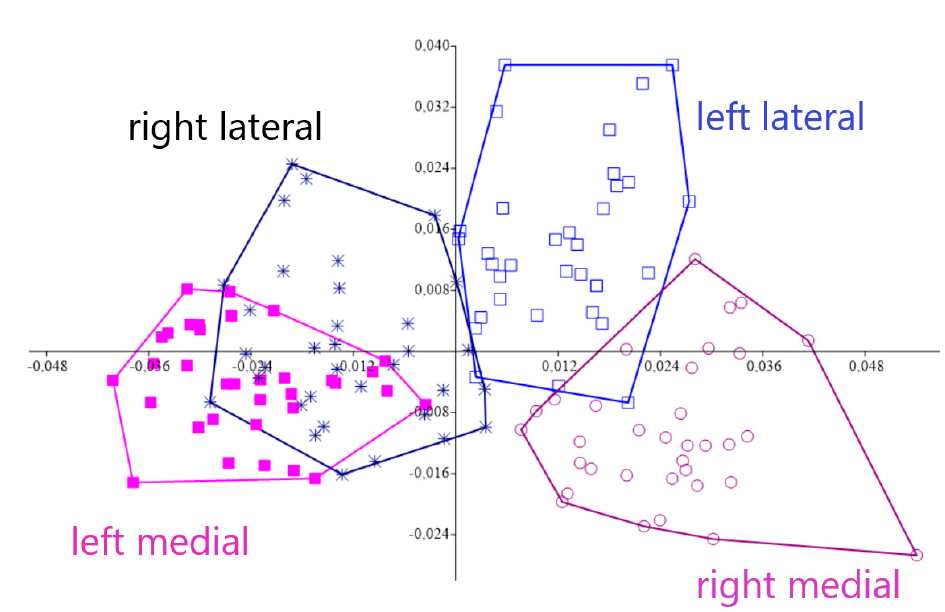
Figure 2. Principal Component Analysis for left and right acropodium asymmetries belonging to 17 Pyrenean Brown calves. The first two Principal Components were statistically meaningful and portrayed 46.80% of the total shape asymmetry, with PC1 accounting for 31.04% of the variance.